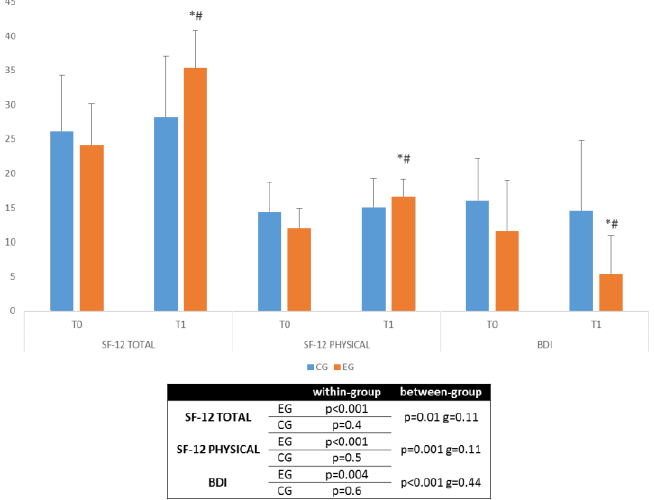
Figure 3. Secondary outcome measures (median + interquartile range). * significant within-group differences, # significant between-group differences. Legend: EG , experimental group; CG , control group; T0, evaluation at baseline; T1, evaluation at the end of the protocol; BDI, Beck Depression Inventory; SF-12 TOTAL, Short-Form-12 Health Survey Total; SF-12 PHYSICAL, Short-Form-12 Health Survey Physical; g, Hedges’ g standardized mean